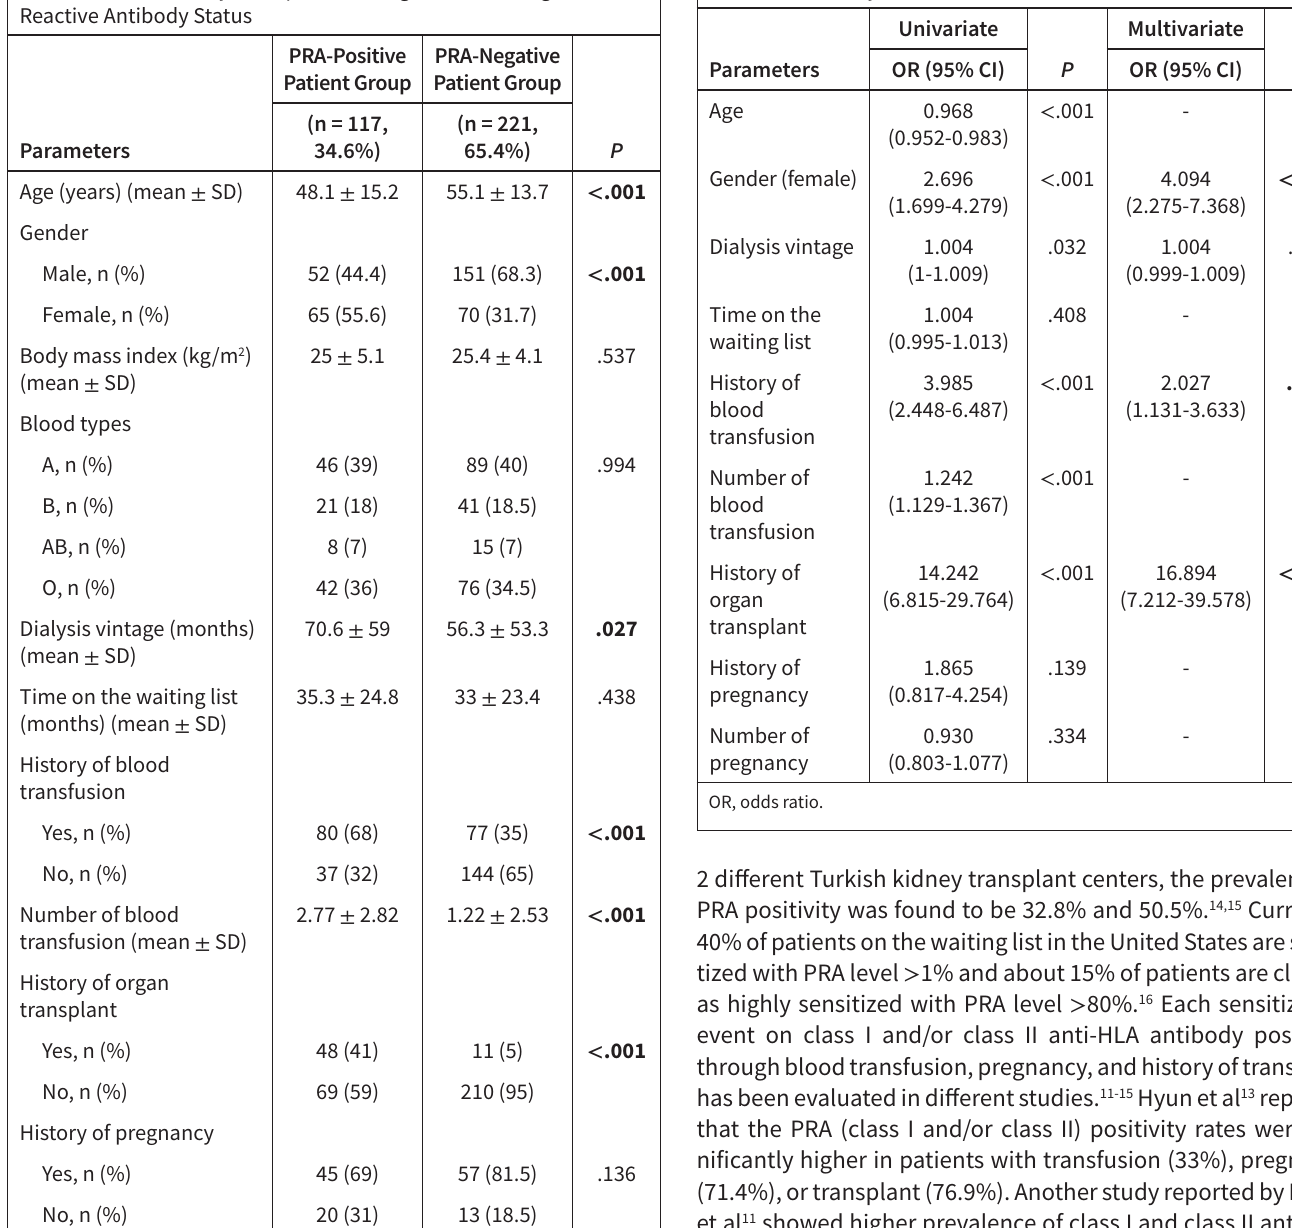
Table 2. Demographic and Clinical Data of Patients on the Table 3. Logistic Regression Model. Risk Factors for Positive Panel Reactive Antibody in